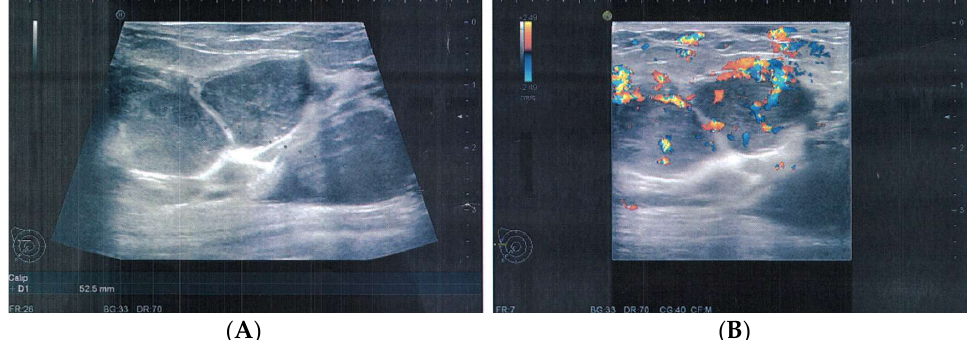
Figure 5. Ultrasonography aspect of local recurrence. ( A ). lobulated, well-circumscribed masses, with smooth margins. ( B ). hypervascularity on color Doppler.